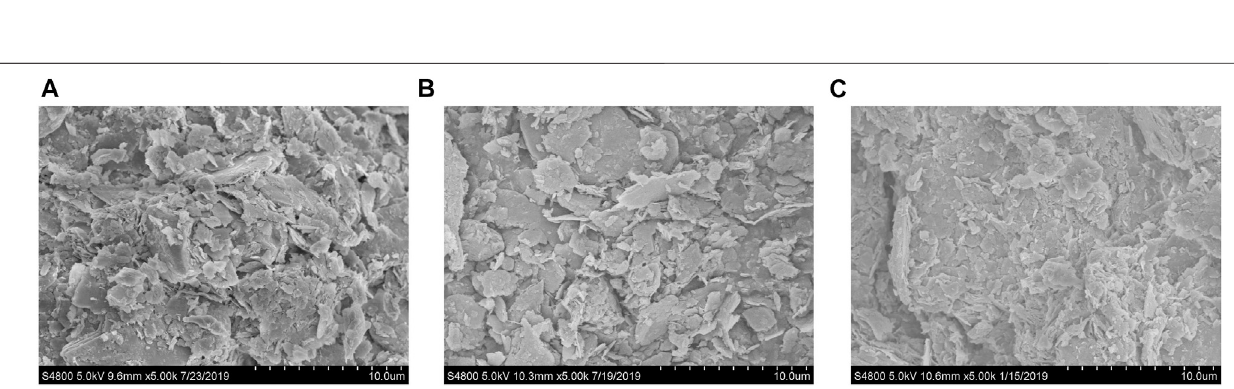
FIGURE 7 | SEM images of solidi fi ed muddy soil with different curing agent contents (A) Curing agent content (1:40) (B) Curing agent content (1:30) (C) Curing agent content (1:20).